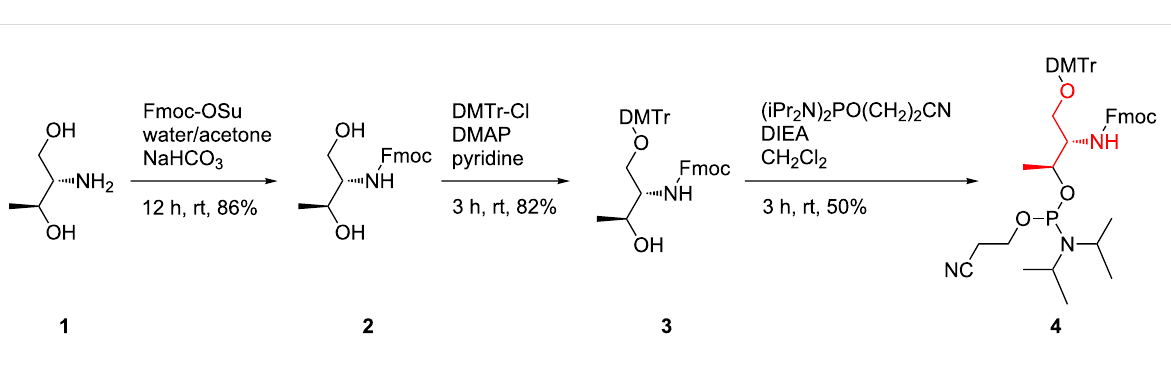
Scheme 1: Synthesis of the phosphoramidite building block 4 [23]. DMTr: dimethoxytrityl group, Fmoc: 9-fluorenylmethylcarbonyl, DMAP: 4-dimethyl- aminopyridine, DIEA: N,N